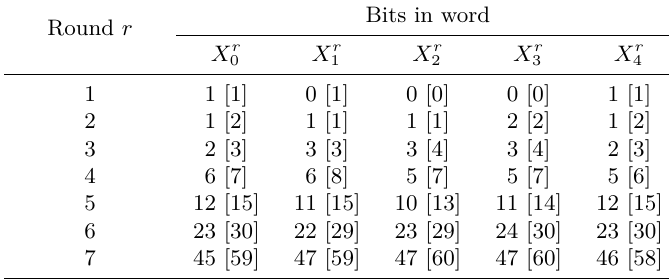
Table 7: Upper bounds on the algebraic degree of Ascon in cube variables. For an incorrect I , the values are shown in [ · ] and taken from [RHSS21, Section 7.2] Round